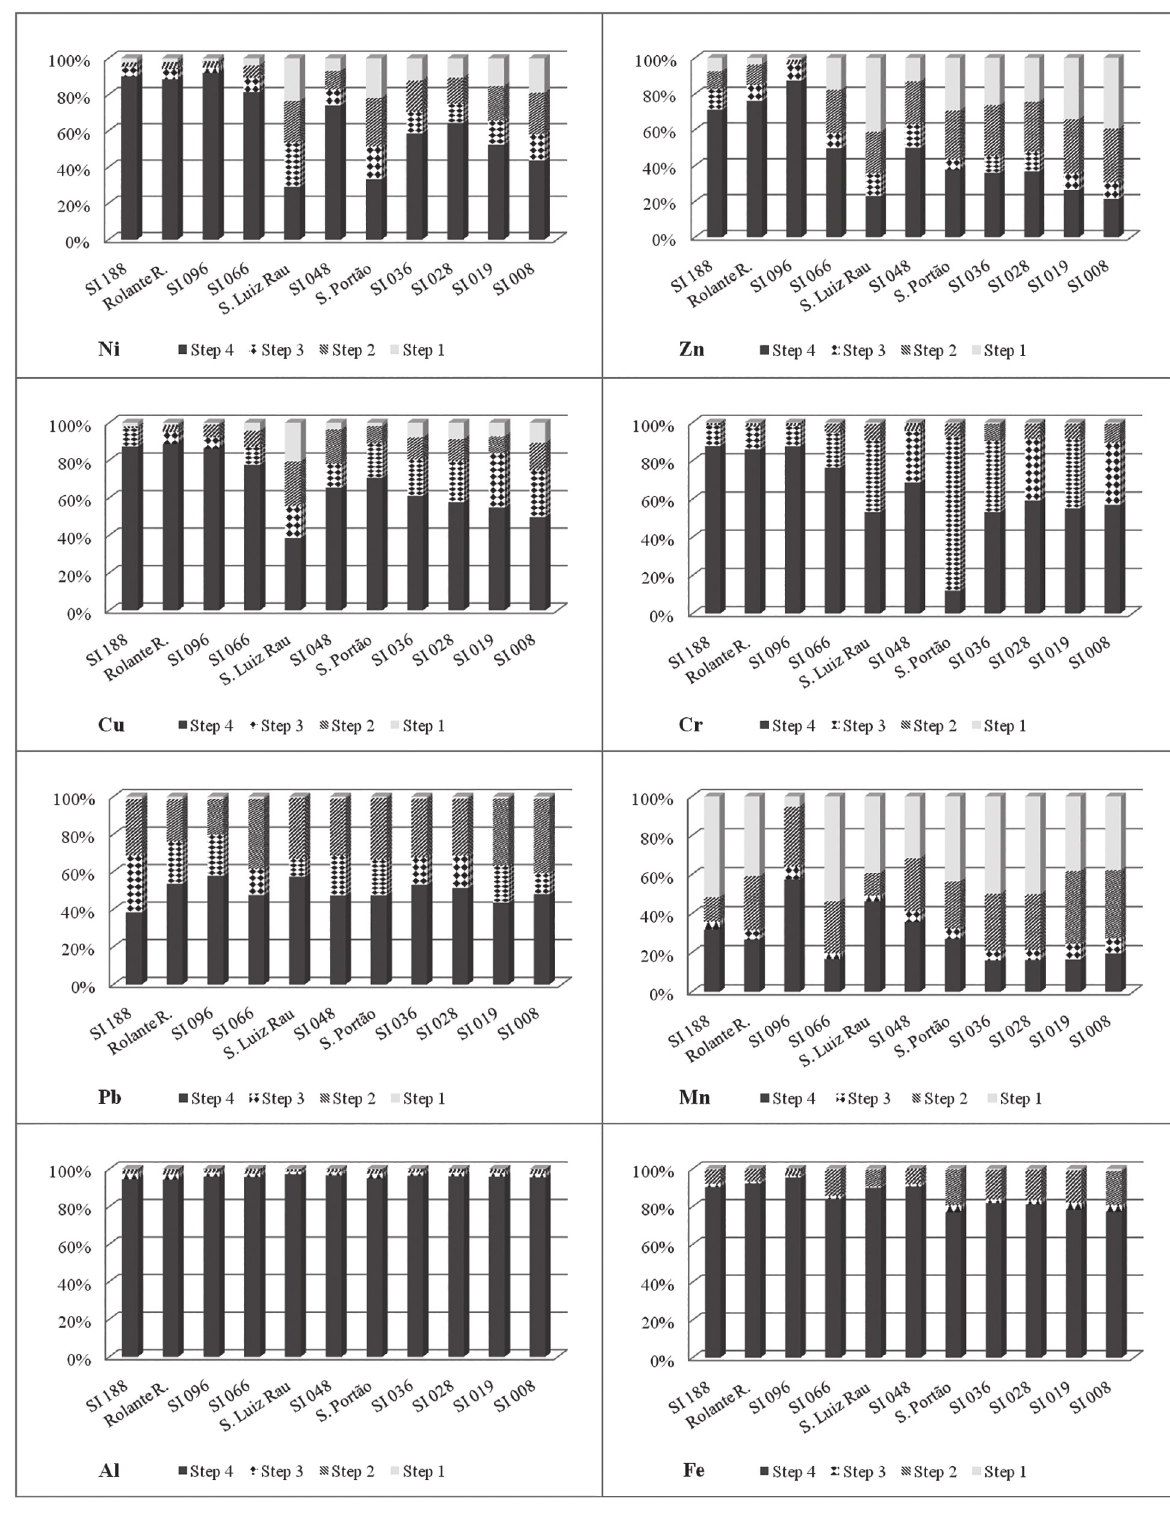
Fig. 2 - Geochemical distribution of Ni, Zn, Cu, Cr, Pb, Mn, Al and Fe in the Sinos River basin sediments (Step 1 = available fraction, i.e., exchangeable and bound to carbonates; Step 2 = reducible fraction; Step 3 = oxidizable fraction; Step 4 = residual